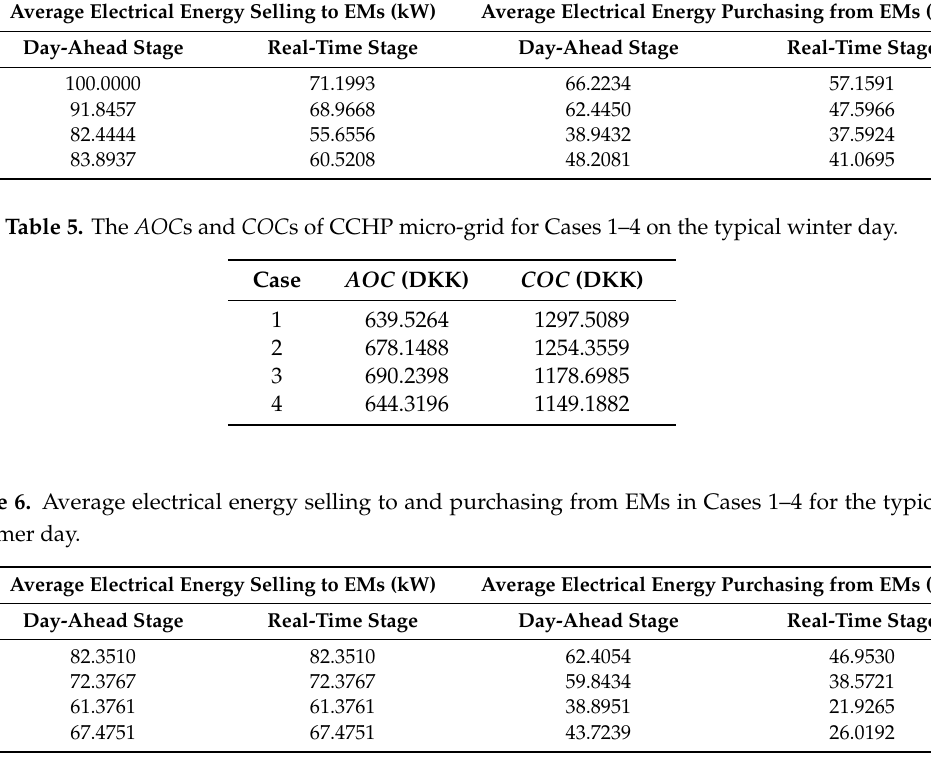
Table 7. The AOC s and COC s of CCHP micro-grid for Cases 1–4 on the typical summer day.